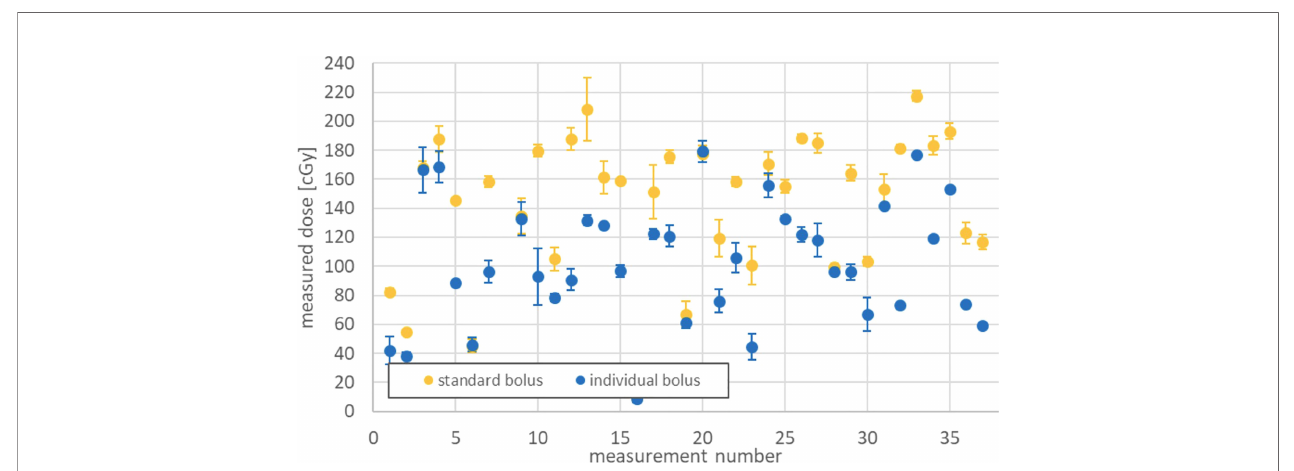
FIGURE 7 | Dose sparing on healthy skin by applying individual